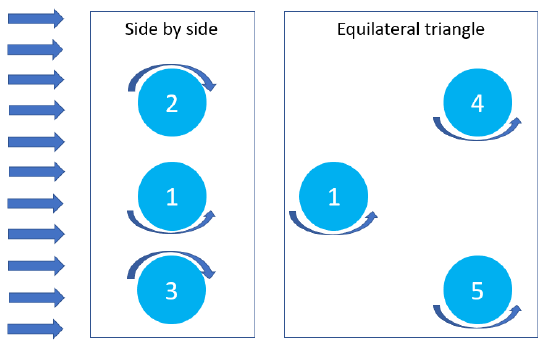
Figure 15. Arrangement of turbines in the two considered configurations (top view); the flow is flowing from left.